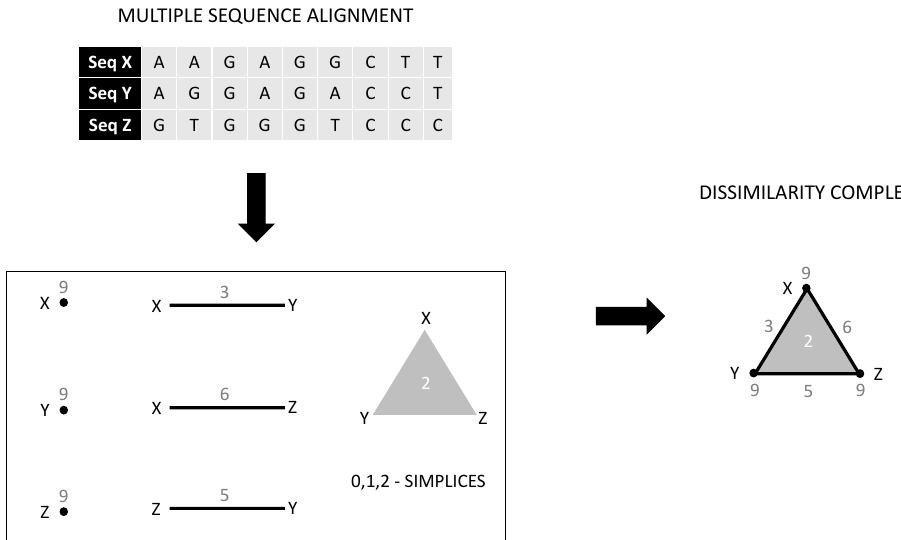
Figure 6. A multiple-sequence alignment of three sequences X , Y , Z , their corresponding weighted simplices, and the associated dissimilarity